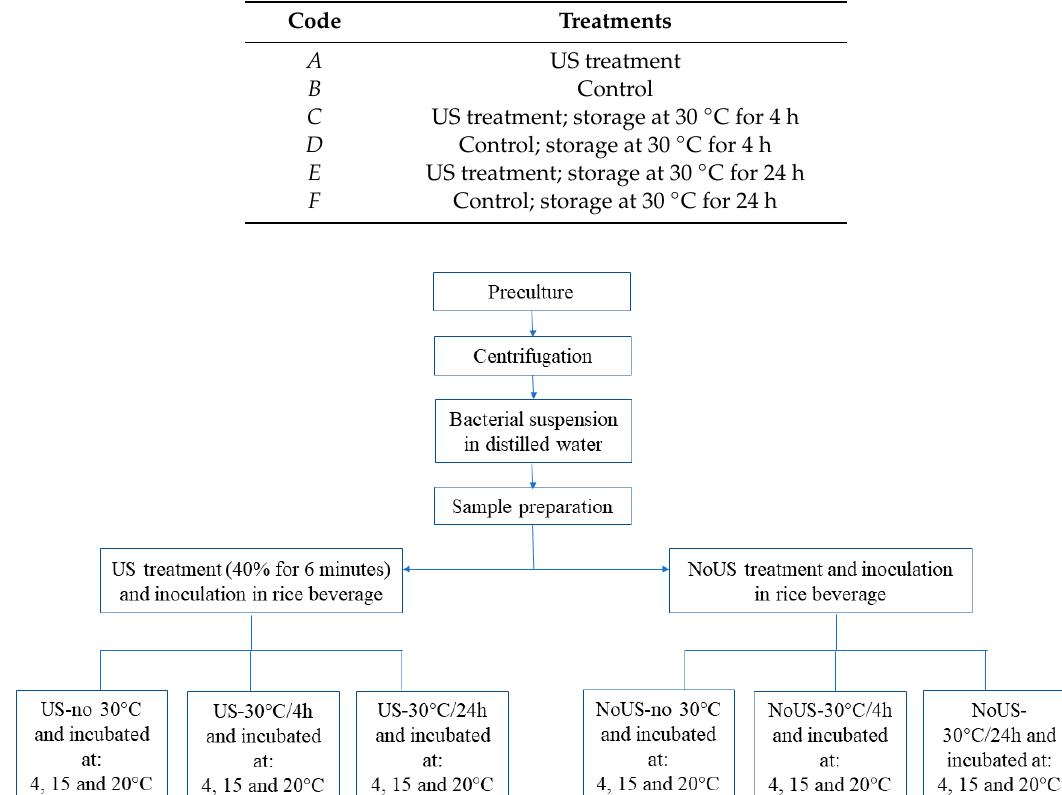
Table 2. Sample codes; experiment on thermal abuse.